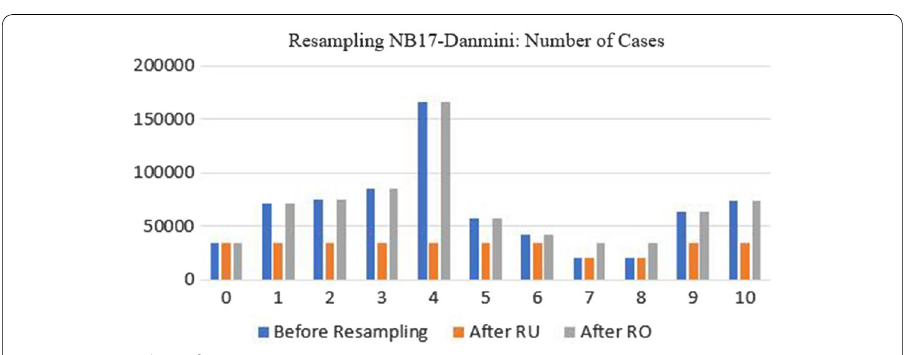
Fig. 14 Resampling of NB17-Danmini